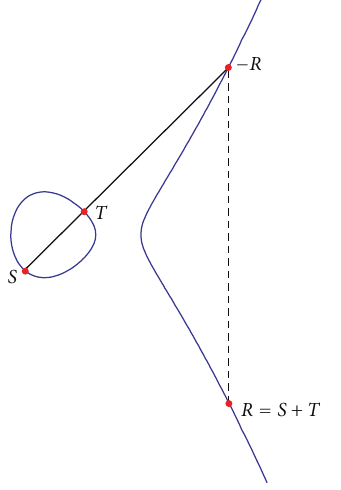
Figure 1: Geometric representation of elliptic curve point addition.